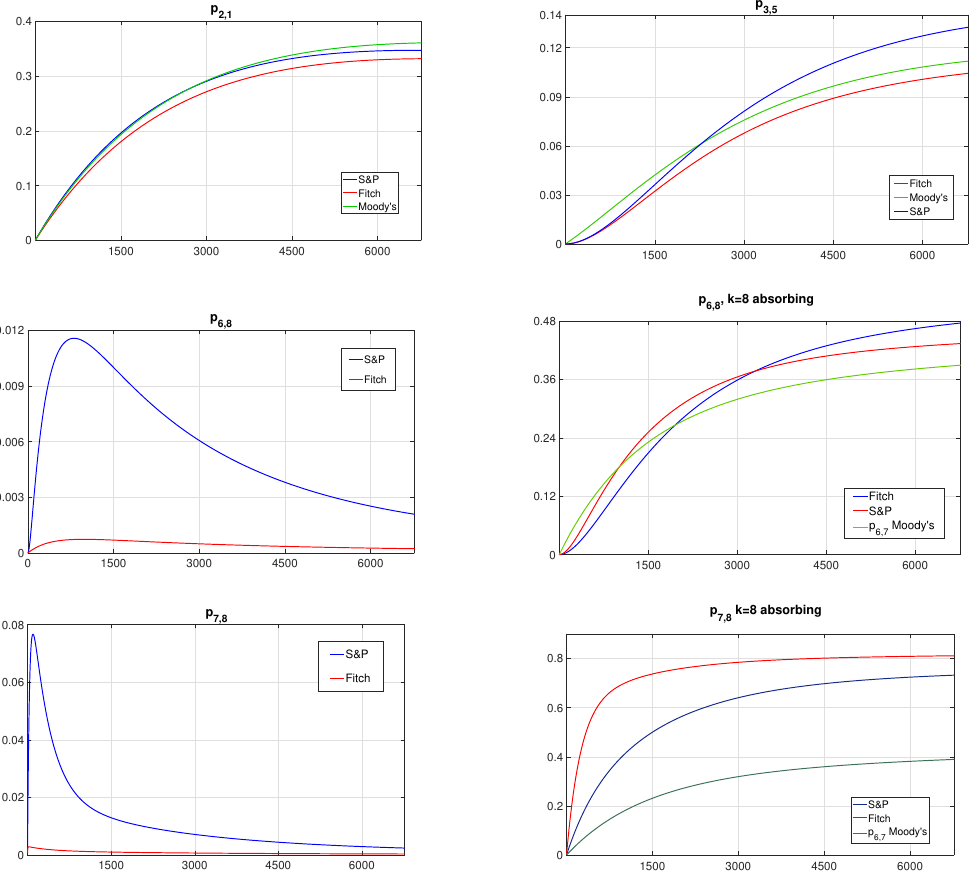
Figure 2. Transition probabilities compared for all agencies over observed